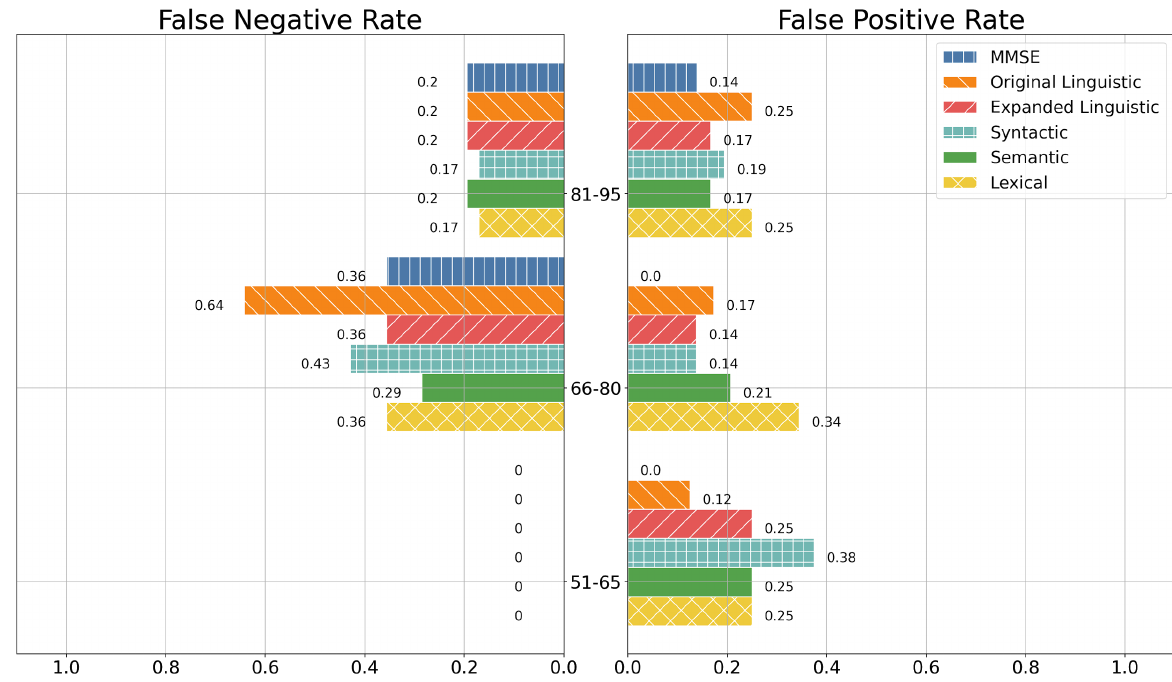
Figure 2. FNR and FPR of the MMSE, Linguistic, Syntactic, Semantic, and Lexical feature sets among age groups. Note: Lack of a bar denotes a proportion error of 0